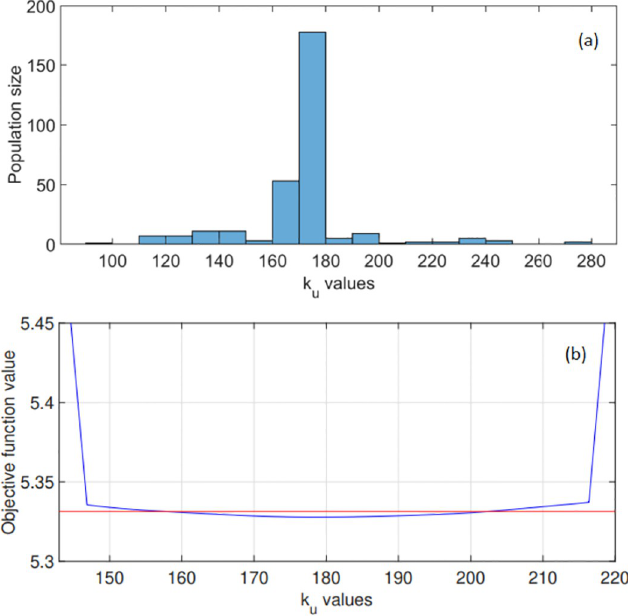
Fig 2. Global optimisation results for the stomatal parameter k u in expression 15. (a) The range of potential k u values considered is shown along with the optimised k u distribution. The genetic algorithm converged to a parameter value on the interval [170, 180], with the optimised k u = 179.4 s. (b) Objective function values: computed profile likelihood for a range of k u values. The 95% confidence interval is shown in red as [157.5, 202.5]